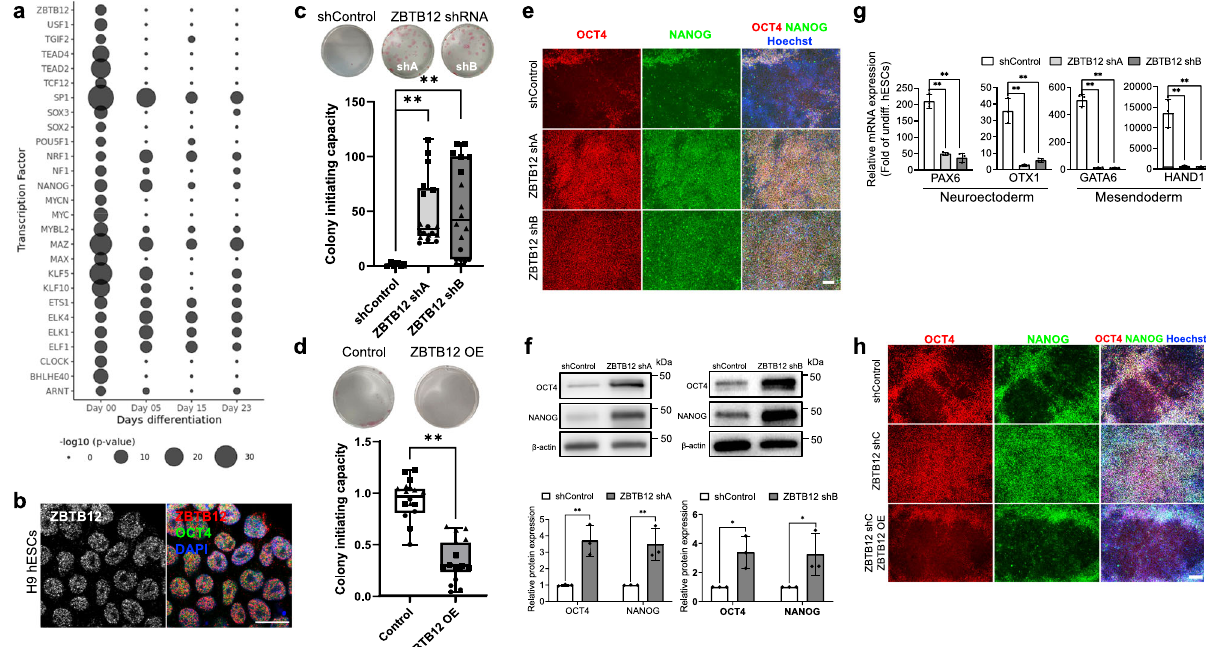
Fig.1|nanoCAGEidenti fi esanewpluripotencyregulatorZBTB12.a Bubbleplot showing Day 0-enriched transcription factors during neuronal differentiation process predicted with HOMER based on promoter sequences (300bp around TSS)of stage-speci fi c transcripts. Twenty-seven transcription factors with p <0.01 and high expression (Cortecon normalized>500 average read counts at day 0 from Cortecon database, GSE56796, https://cortecon.neuralsci.org) were selected andshown.Sizeofthecirclerepresentsthe − log 10 p valueoftranscriptionfactors. P valuewascorrectedbytheBenjamini – Hochbergmethod. b Representativeimages from three independent immuno fl uorescence assays for ZBTB12 and OCT4 in H9